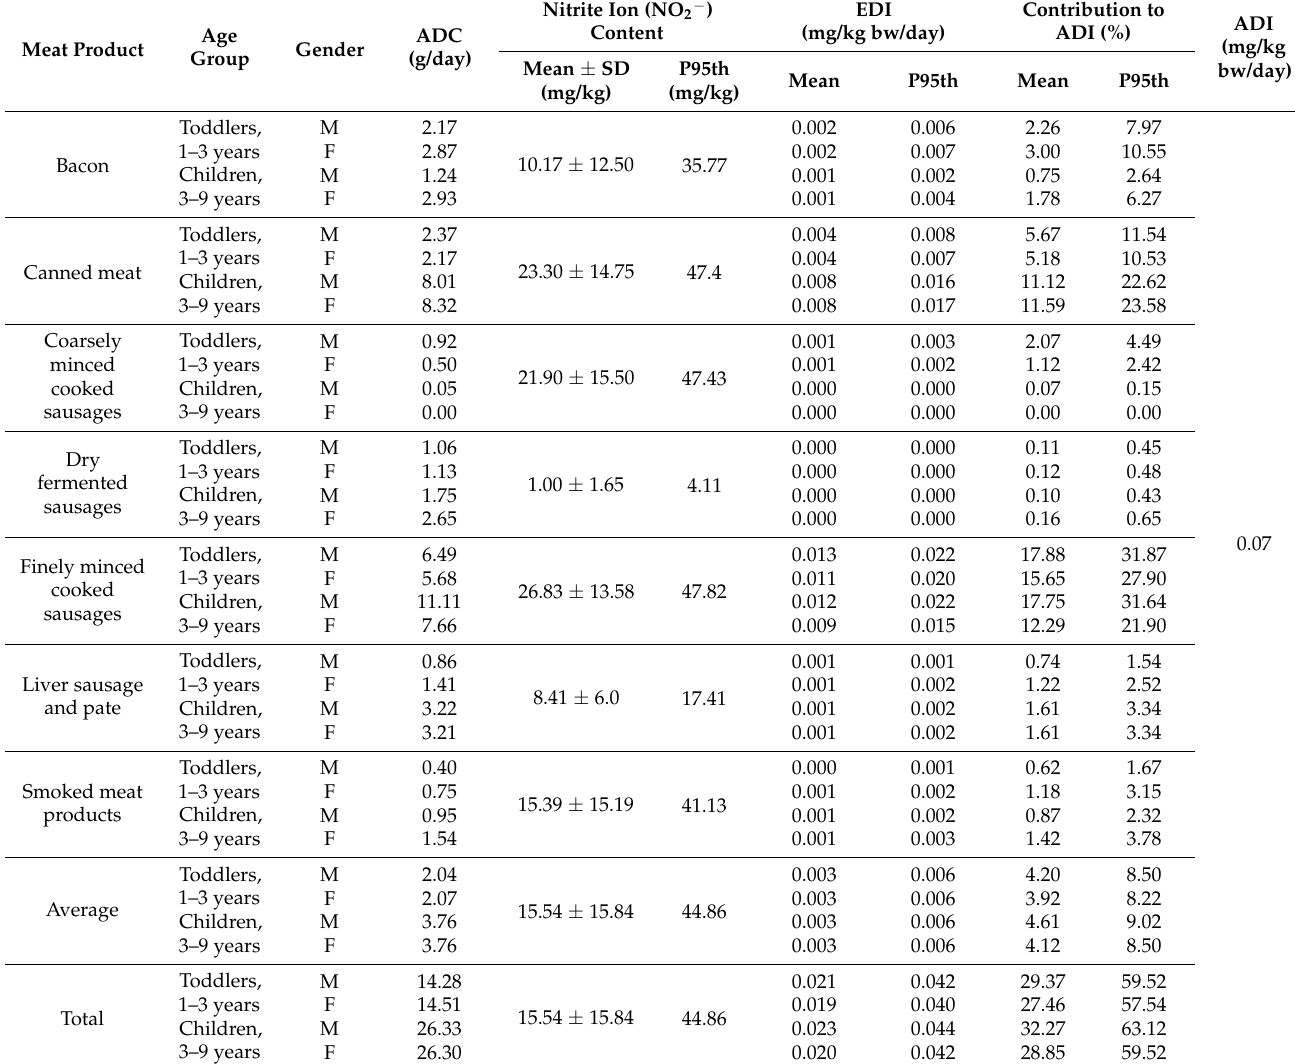
Table 4. EDI and risk characterization of nitrite ion (NO 2 − ) intake through processed meat